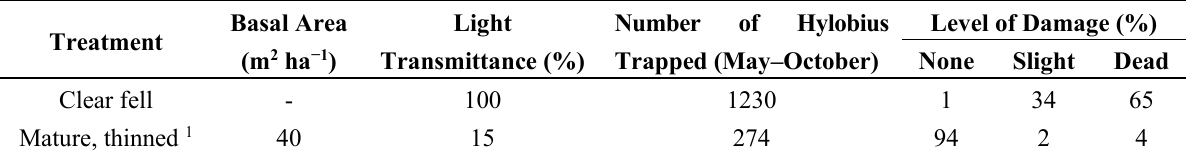
Table 2. Incidence of damage from Hylobius abietis on Sitka spruce transplants planted on a clear felled area or under a canopy of mature Sitka spruce trees (adapted from Mason et al.